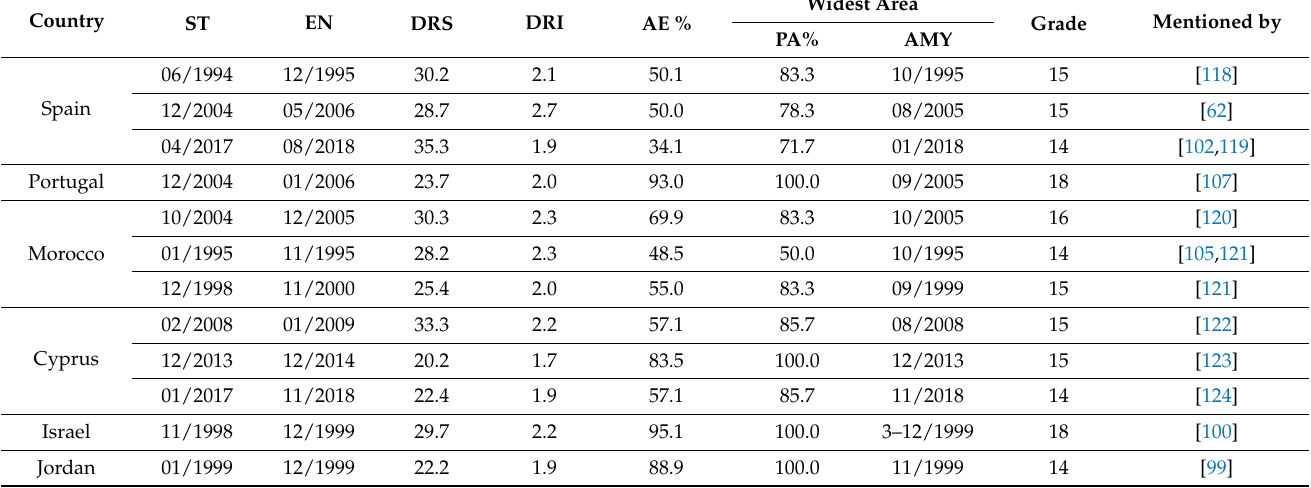
Table 6. List of subregional exceptional drought events across the MED detected by DXI-12 at the country level that were identified according the new grade classification,